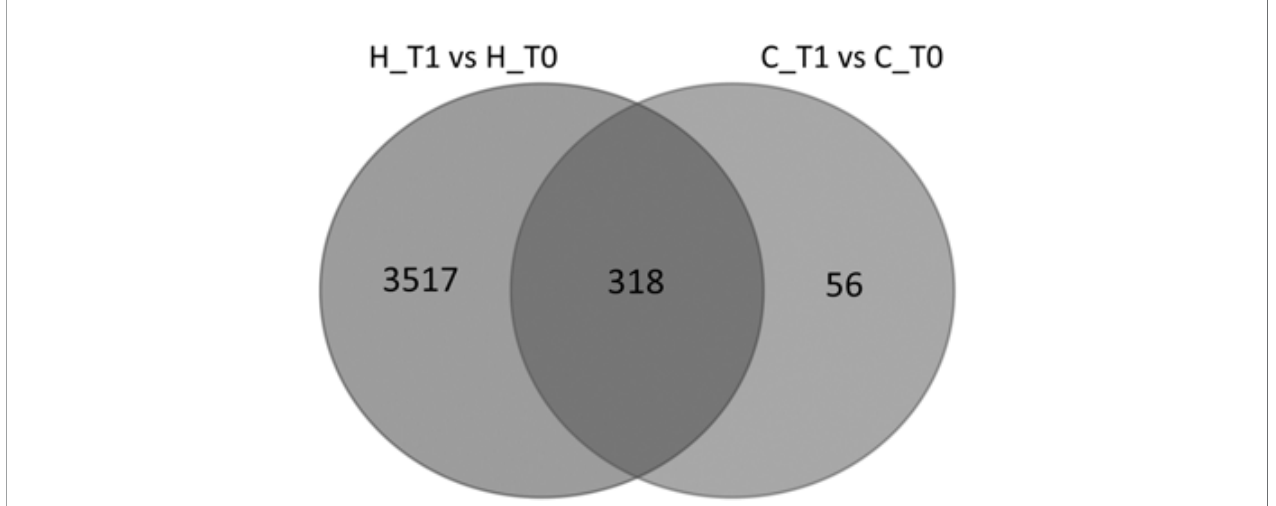
FIGURE 2 | Venn diagram representing the intersection between the list of differentially expressed genes (DEGs) ( p -value < 0.05 and FDR < 0.05) in milk somatic cells (MSCs) from goats fed with the hemp seed (H) diet and control (C) diet in the two time points (T0 and